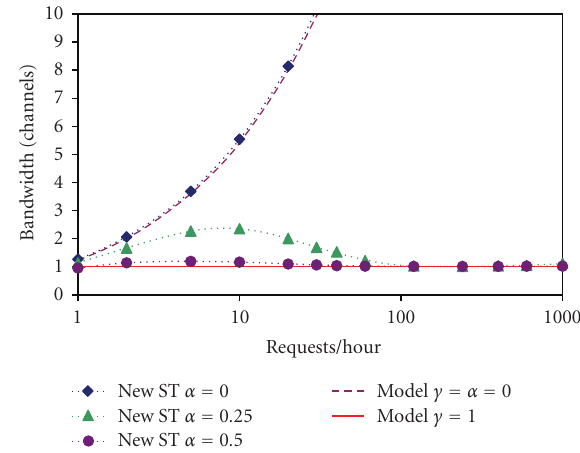
Figure 8: Server bandwidth requirements of the new stream tapping